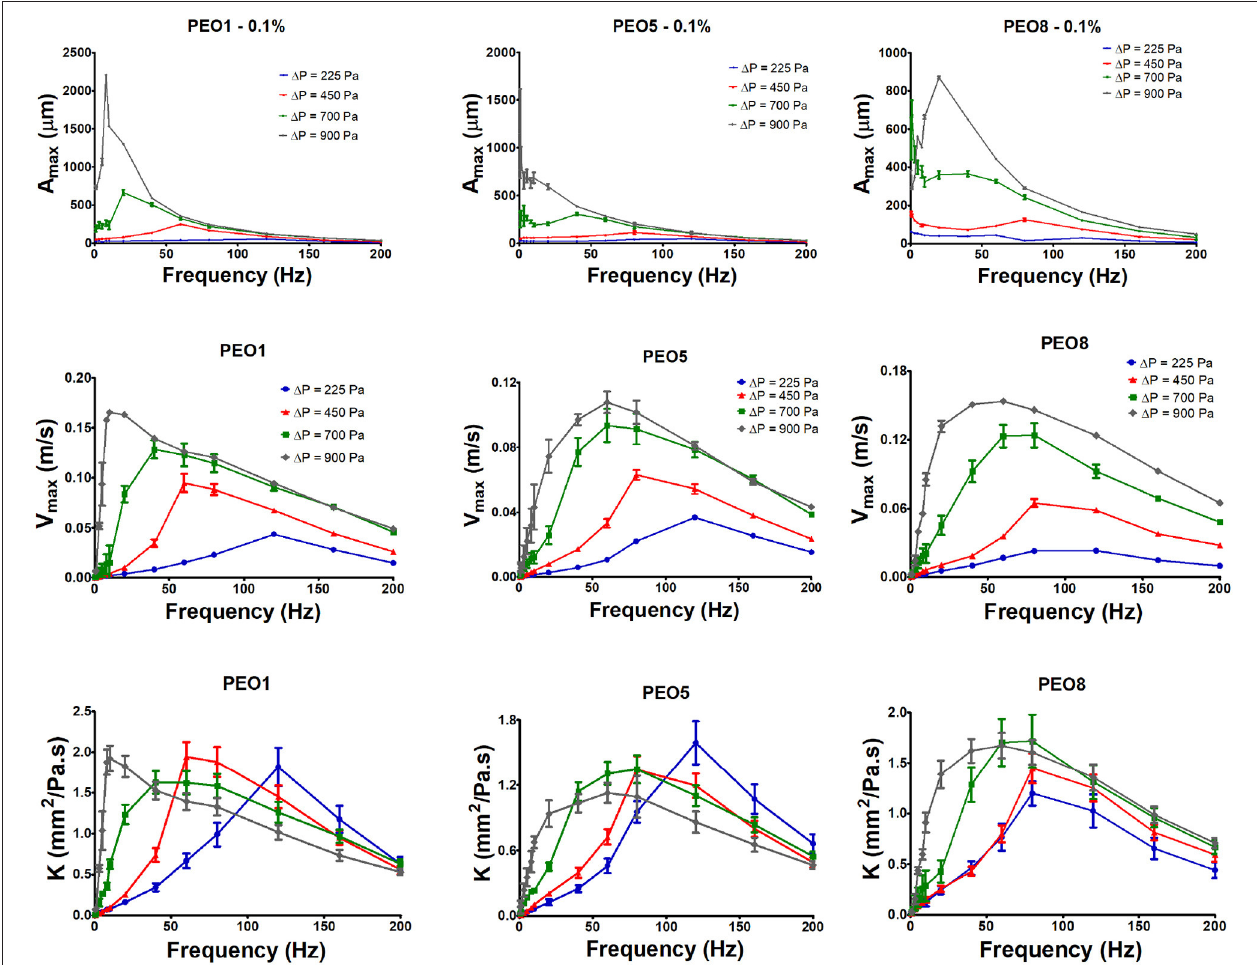
FIGURE 6 | Maximum amplitude of displacement, maximum amplitude of velocity and modulus of dynamic permeability, as a function of driving frequency for the three PEO polymeric solutions and 4 different maximum amplitudes of the driving pressure drop.